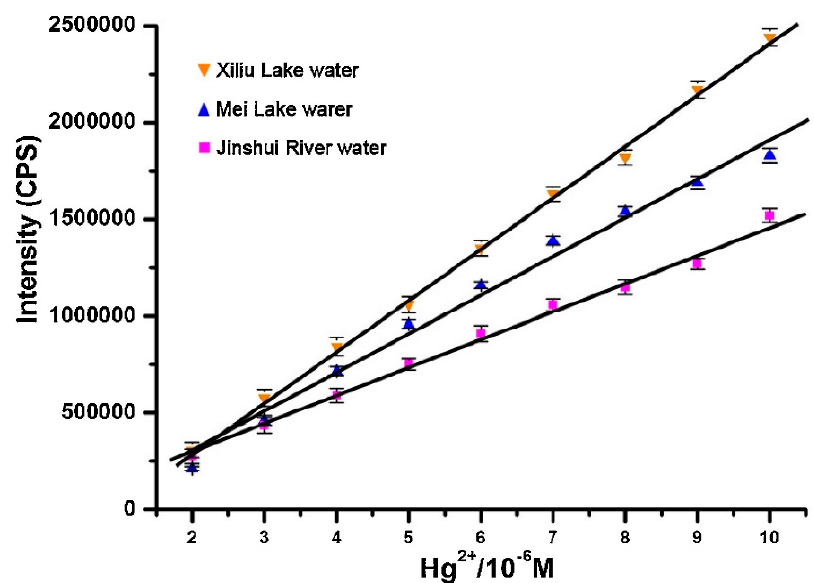
Figure 12. Hg 2+ detection carried out by the rhodamine B derivative in three different natural water samples. Reprinted with permission from [185].